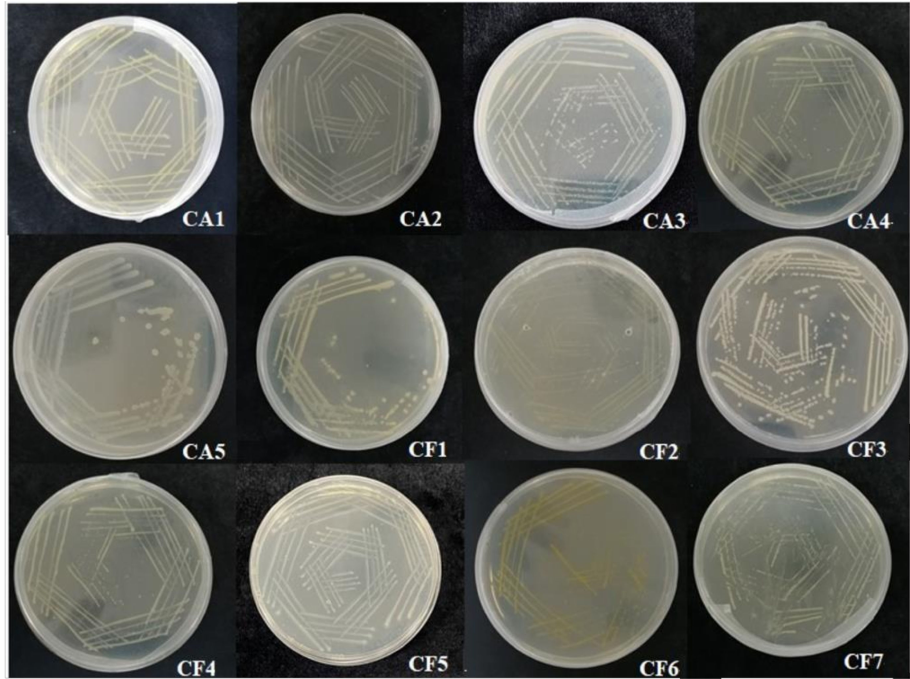
Figure 1. Colonies of the 12 phycosphere bacteria isolated from C. dentata .